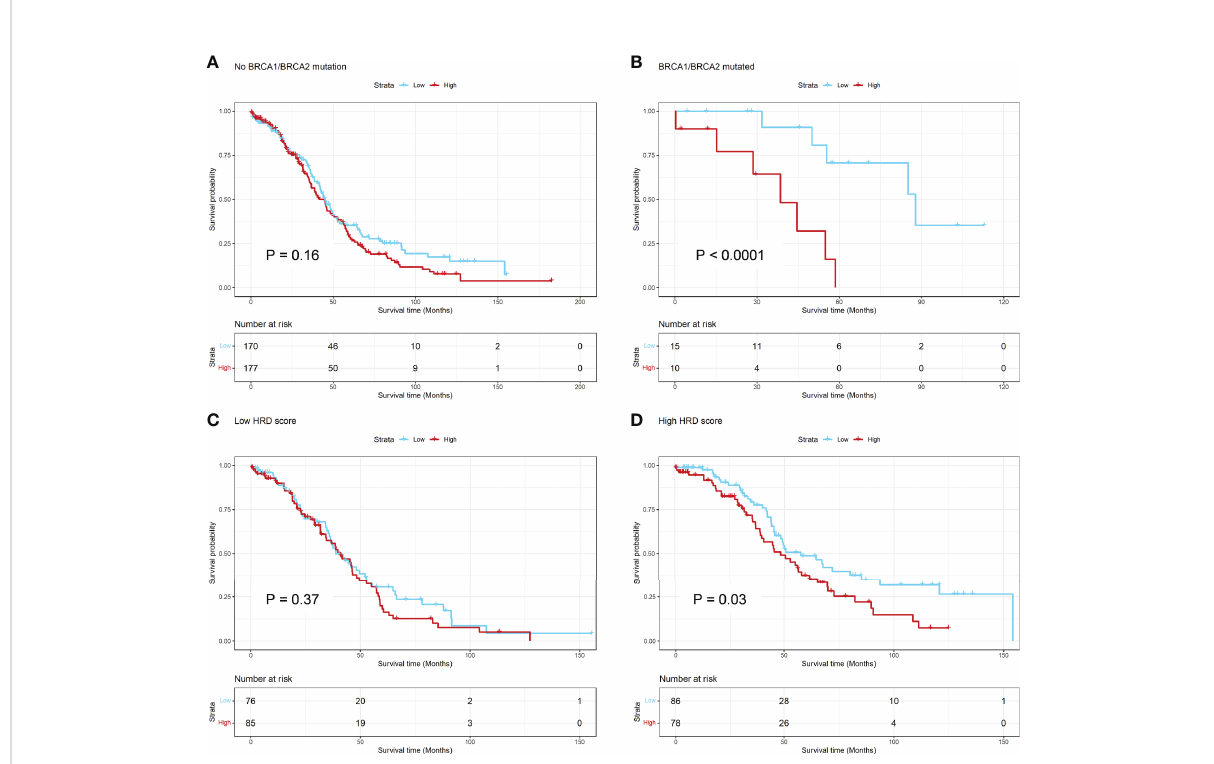
FIGURE 3 Hierarchical Analysis for BRCA1/2 mutation and HRD Score in TCGA dataset. (A, B) The Kaplan-Meier survival curve of OS between the ADO groups for subgroups of patients with or without BRCA1/2 mutation, respectively; (C, D) The Kaplan-Meier survival curve of OS between the ADO groups for subgroups of patients with low or high HRD score,